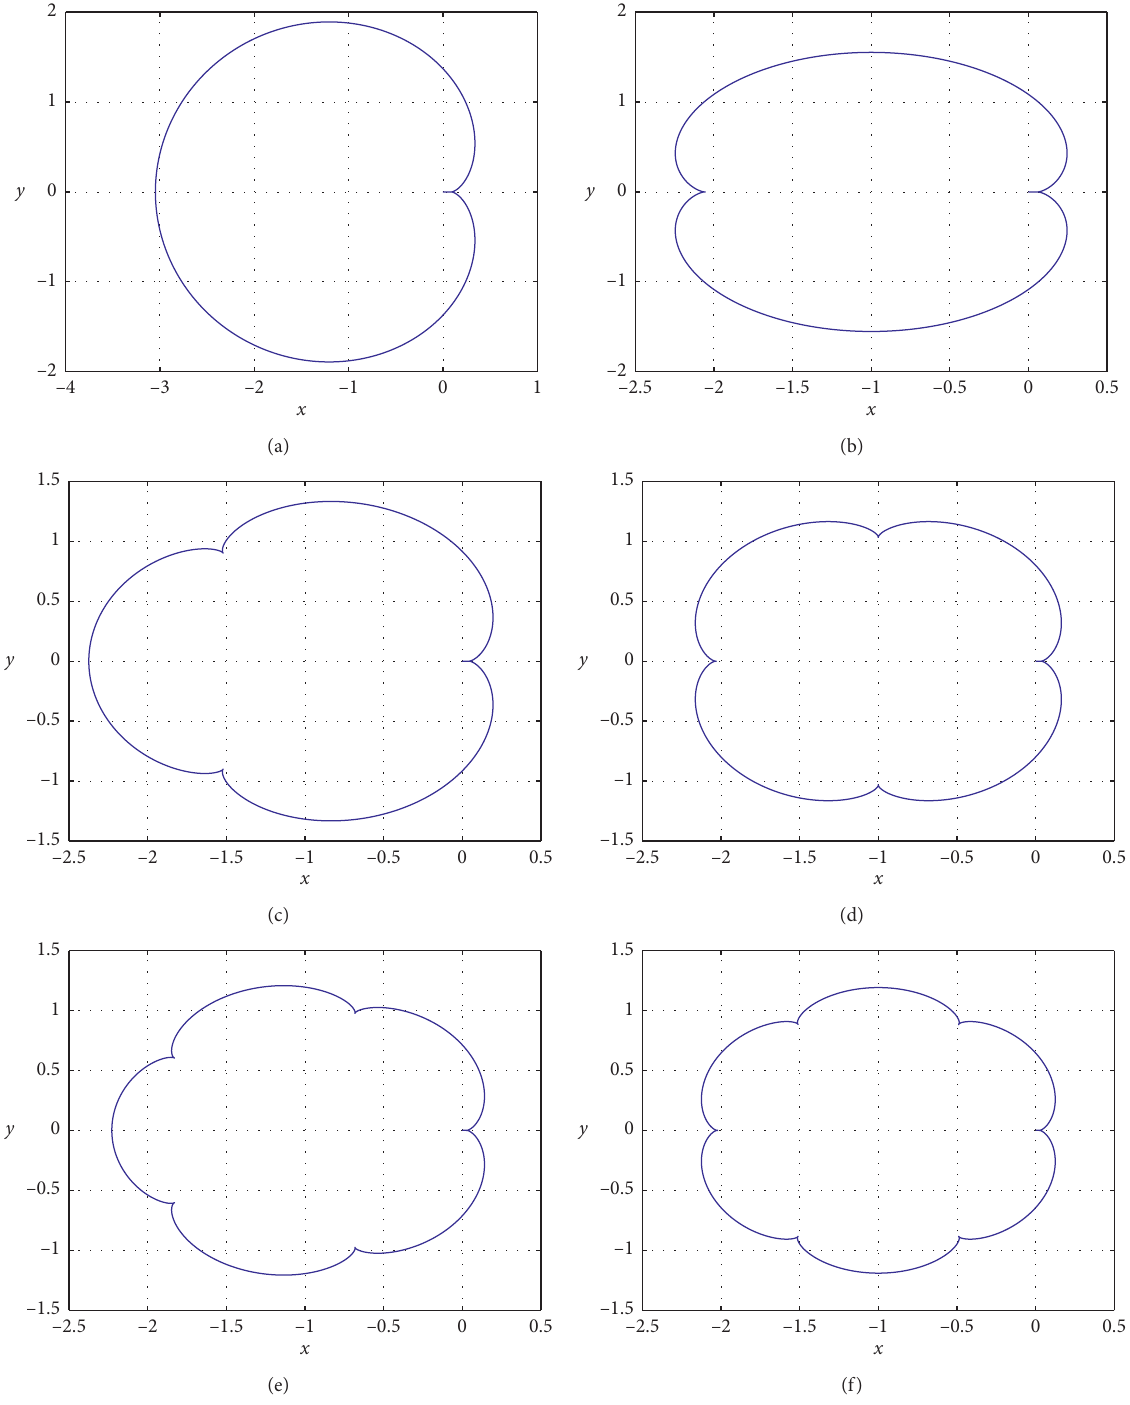
Figure 7: Periodic orbits when e � 0 . 2 ,f 0 � π /6, and velocity _ y 0 � 0 . 002. (a) One-loop orbit, when x 0 � 0.088265415. (b) Two-loop orbit, when x 0 � 0.0567688625. (c) Three-loop orbit, when x 0 � 0.041657425. (d) Four-loop orbit, when x 0 � 0.032808755. (e) Five-loop orbit, when x 0 � 0.026999870500. (f) Six-loop orbit, when x 0 �